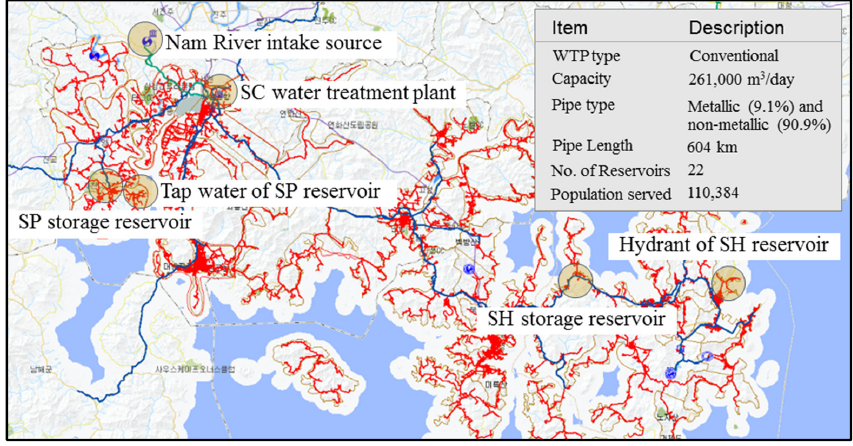
Figure 5. Schematic representation of the SC City water supply system.